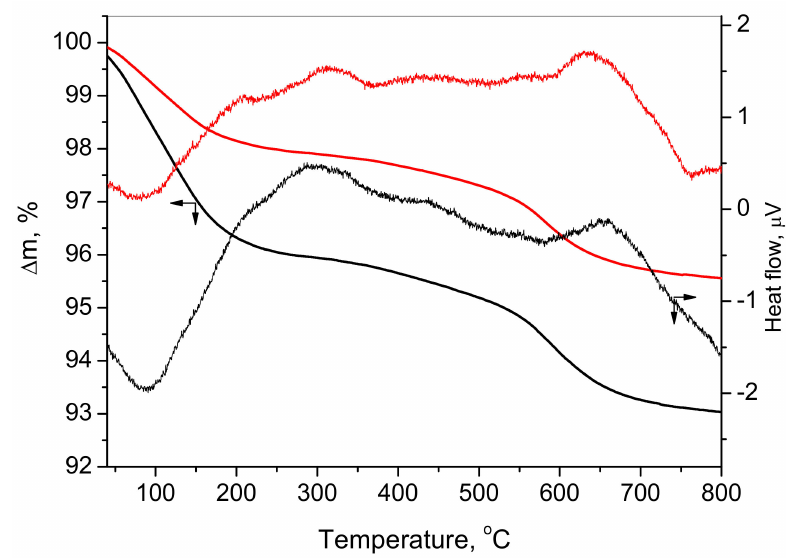
Figure 4. TG and DTA curves of MCF-S (black) and MCF-CA (red).